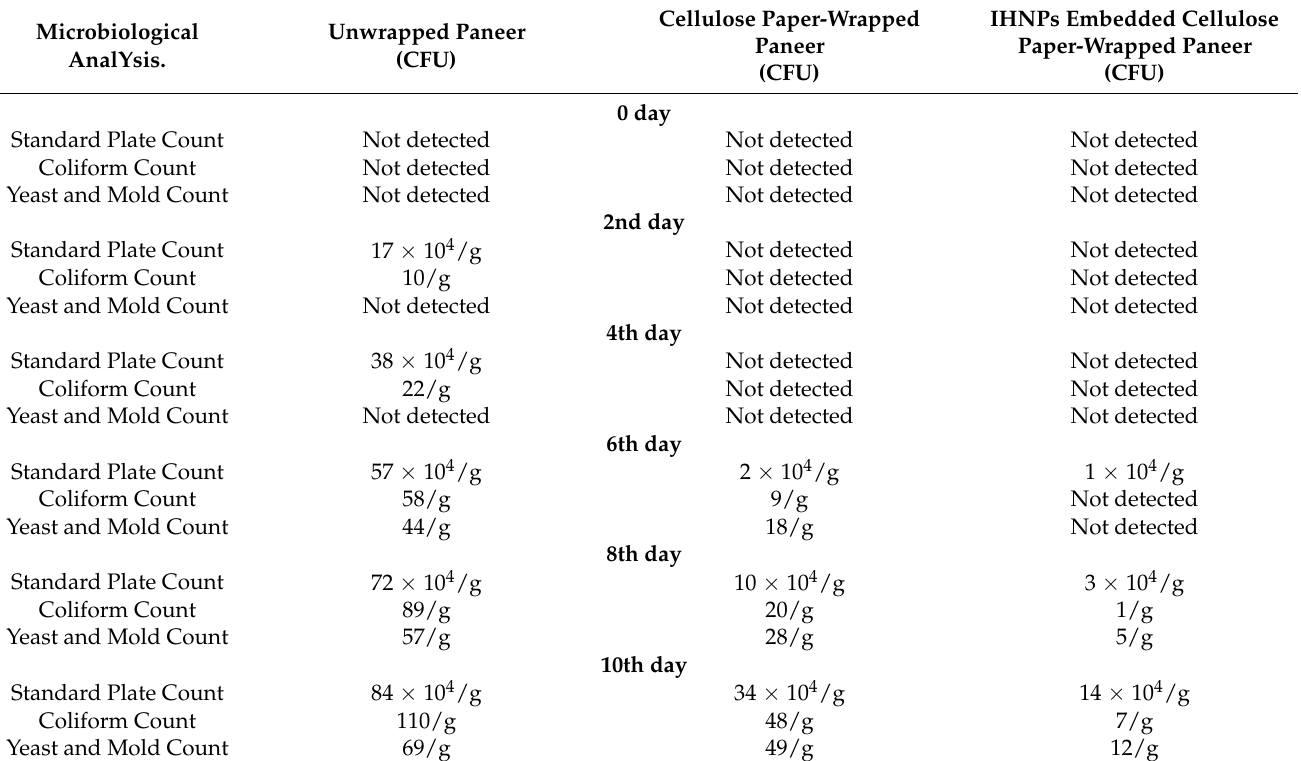
Table 1. Shelf-life study of cellulose paper-wrapped